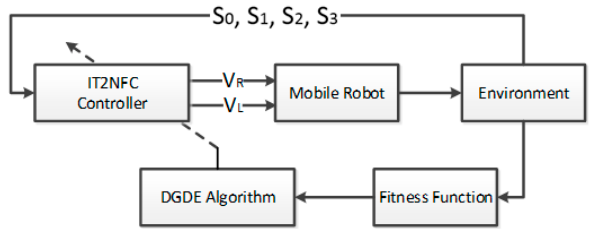
Figure 10. Block diagram of the mobile robot wall-following control.